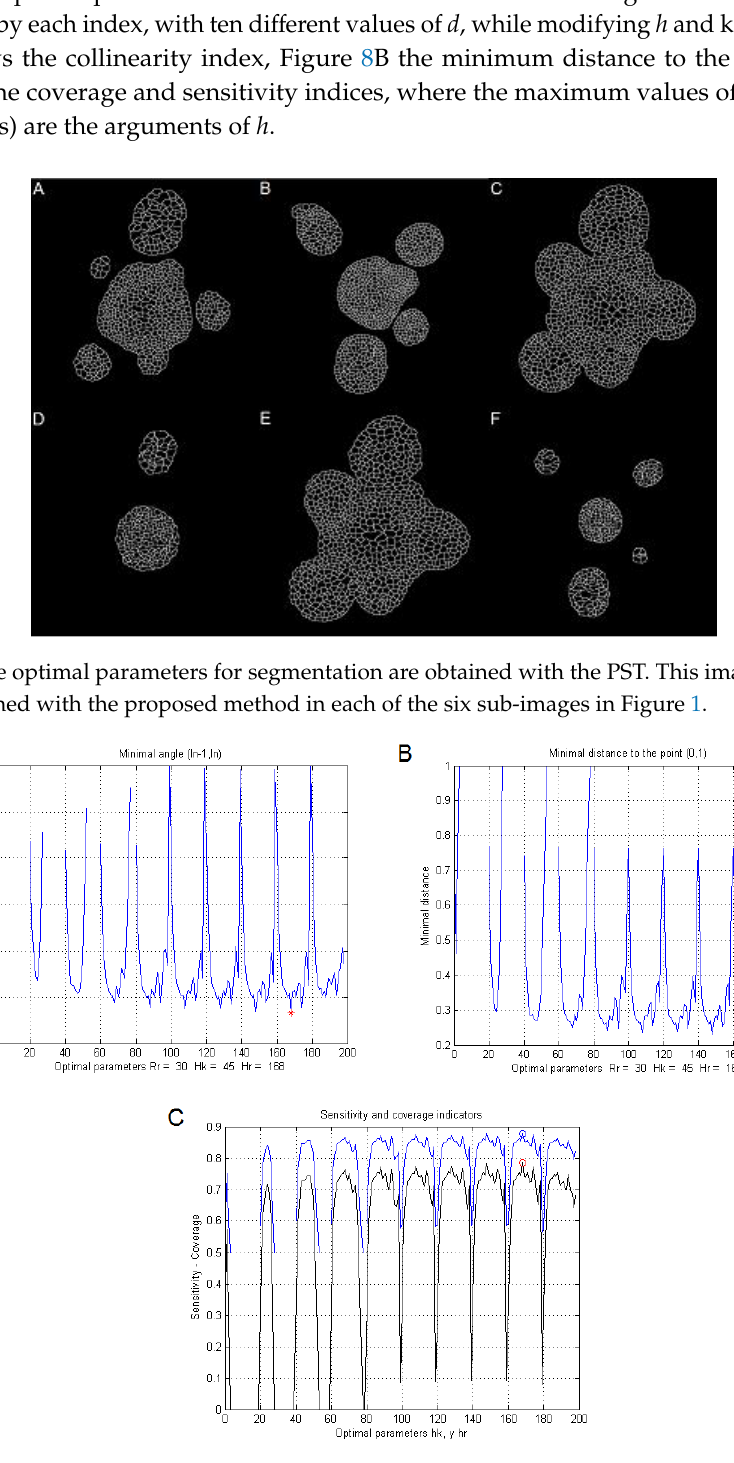
Figure 8. Curves of the similarity indices obtained from the tuning of the segmentation technique on the image in Figure 7A. ( A ) Co-linearity indicator. ( B ) Minimum distance indicator. ( C ) Coverage and sensitivity indicators. All the curves vary in the range between 0 and 20, but to allow comparing and visualizing the minimum point. They were displaced in intervals of 20 between one and the other.